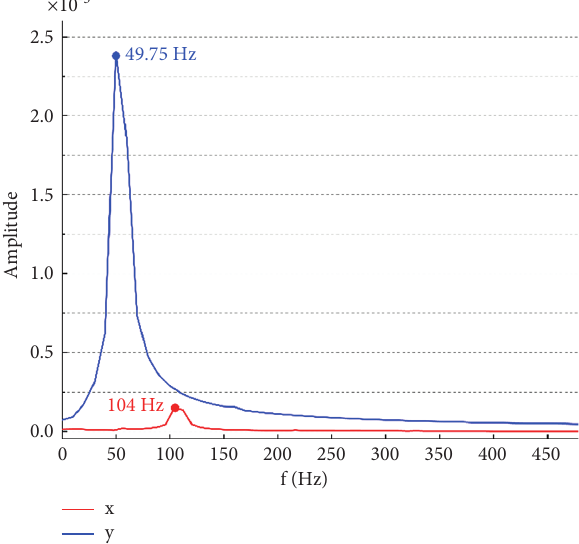
Figure 15: X and Y axial displacement response frequency